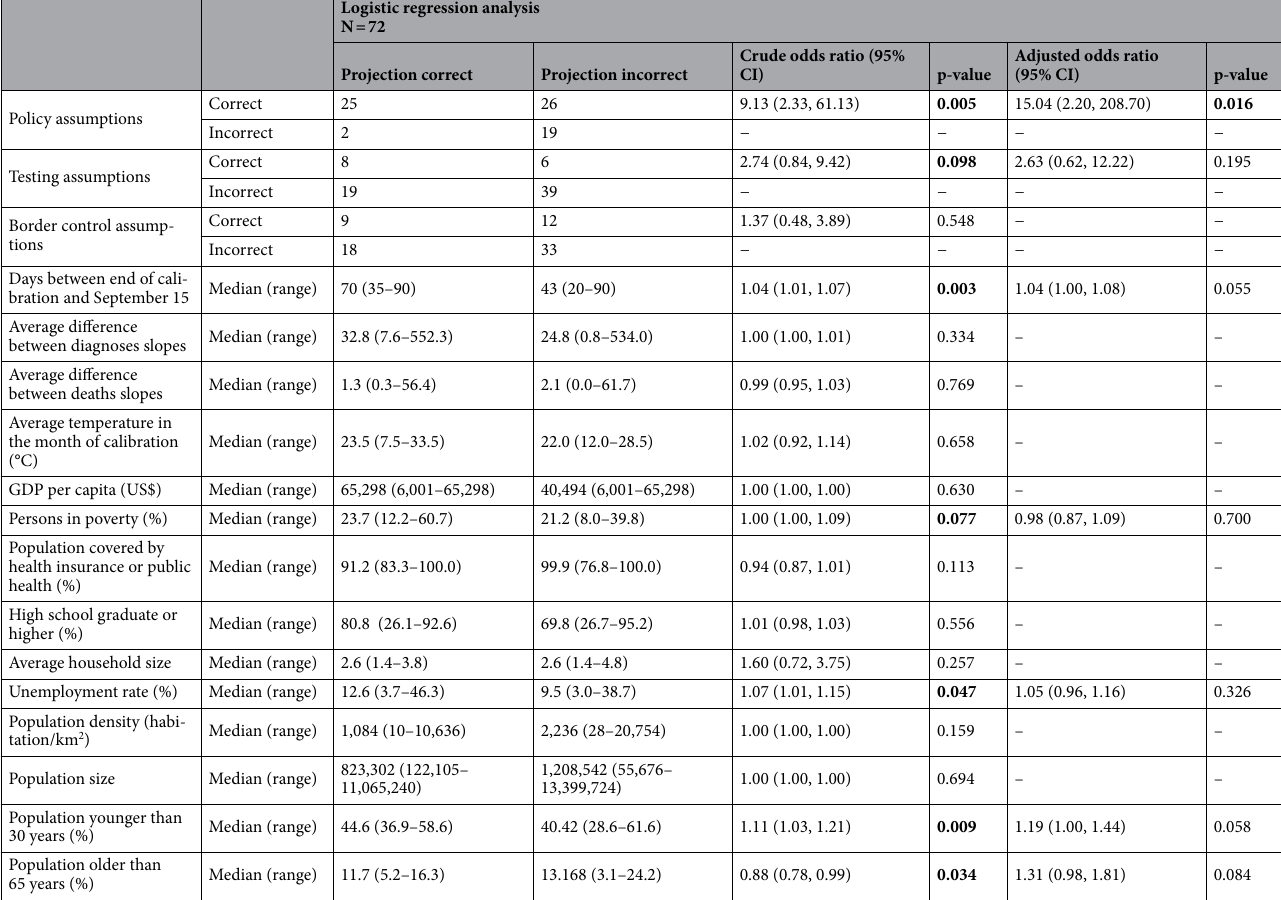
Table 2. Logistic regression results for model projection accuracy. Significant values are in